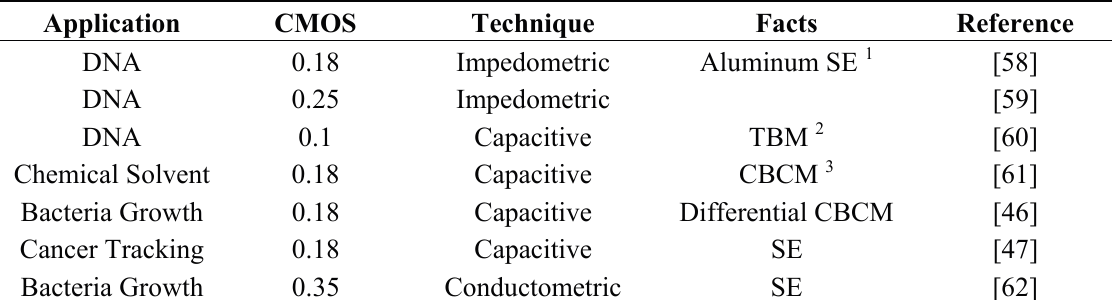
Table 2. CMOS based impedometric or capacitive